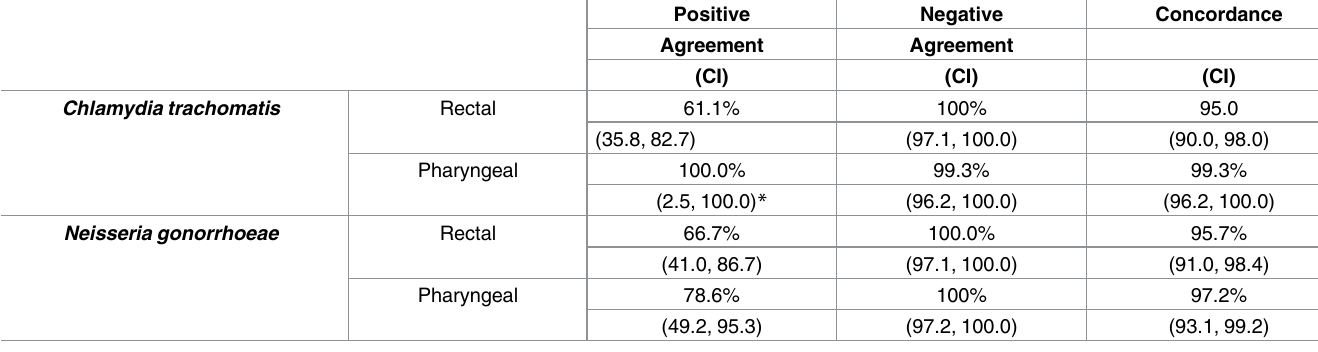
Table 2. Concordance between in-home self-collected and clinic-collected CT/NG specimens using the GeneXpert ®